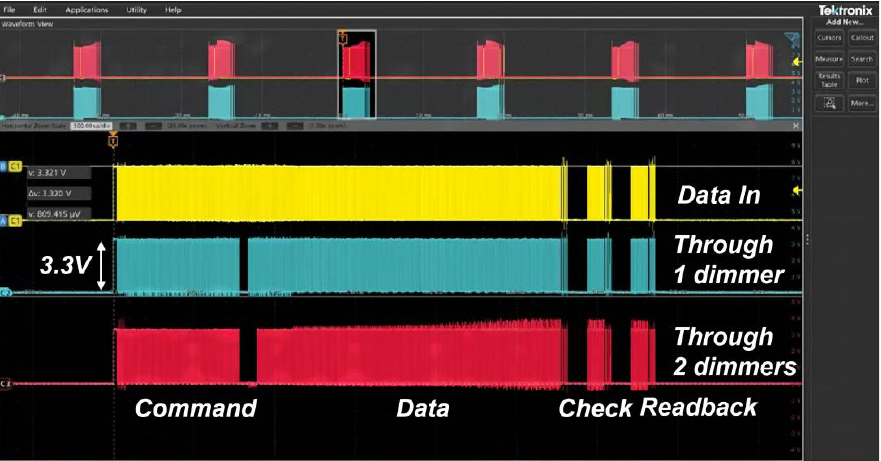
Figure 8. Measurement results of the X-wire driving waveforms of DCON output through the first dimmer and second dimmer.